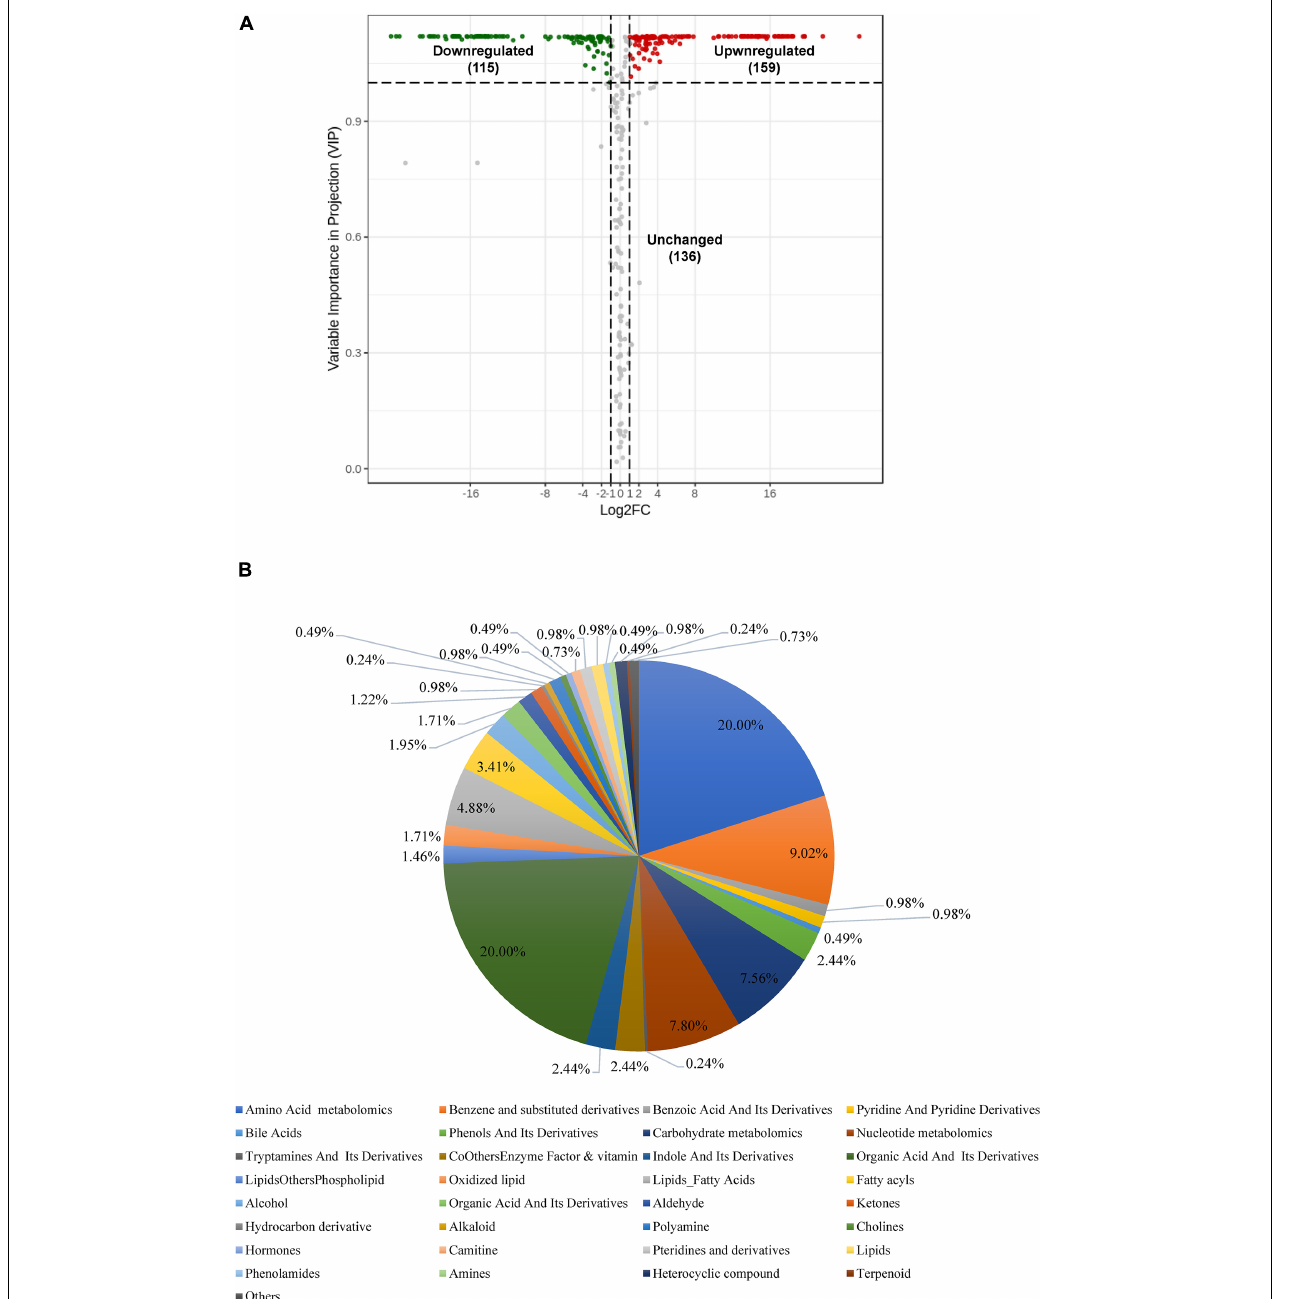
FIGURE 5 | Differential accumulation of metabolites between Aspergillus niger and Bacillus sp. (A) Volcano plot of the 410 identified metabolites. Differential metabolites were defined as metabolites with a fold change of ≥ 2 or ≤ 0. 5 in Aspergillus niger compared to Bacillus sp. A threshold of VIP ≥ 1 was used to separate differential metabolites from unchanged metabolites. (B) Pie chart depicting the biochemical categories of the differential metabolites identified between Aspergillus niger and Bacillus